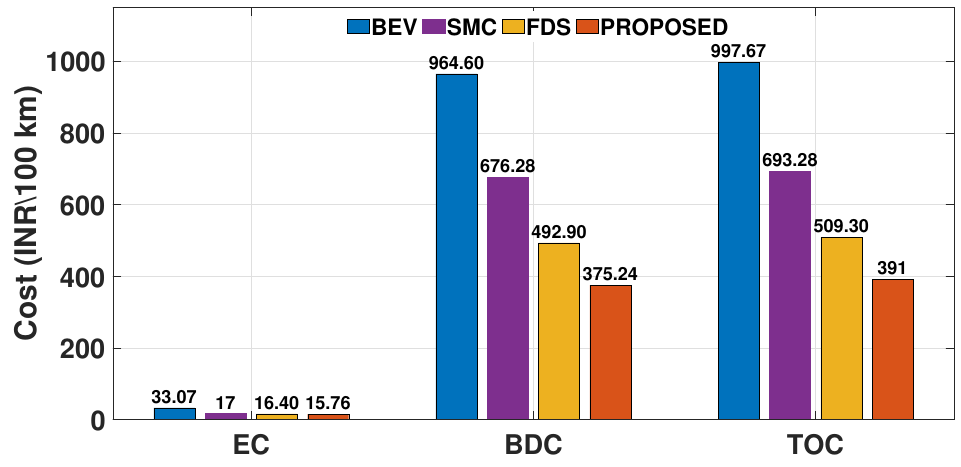
Figure 19. Economic analysis of EV with SMC, FDS, BEV, and